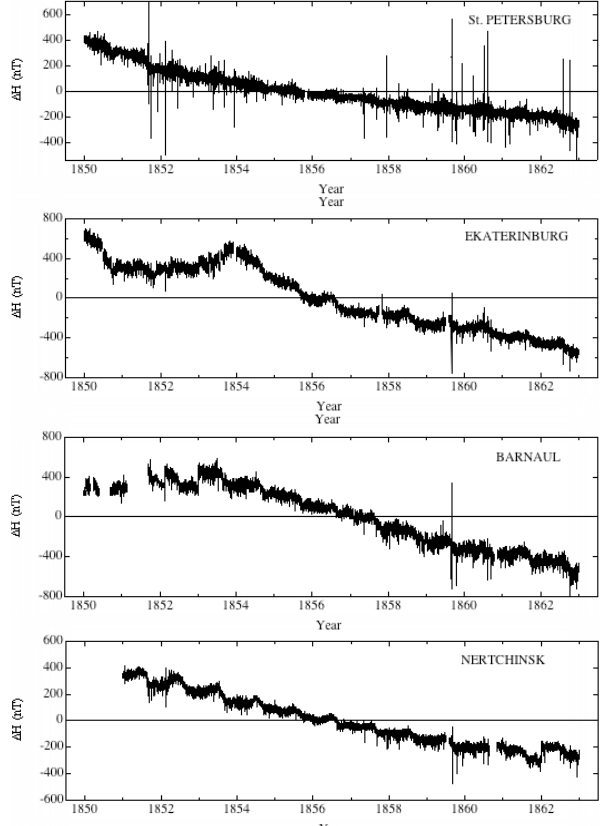
Fig. 3. Black: Hourly values (spot readings) of magnetic decli- nation ( 1D) (in minutes) for 1850–1862. Spikes represent mag- netically disturbed storm hours. Red: Secular variation of D from Golovkov et al. (1983).